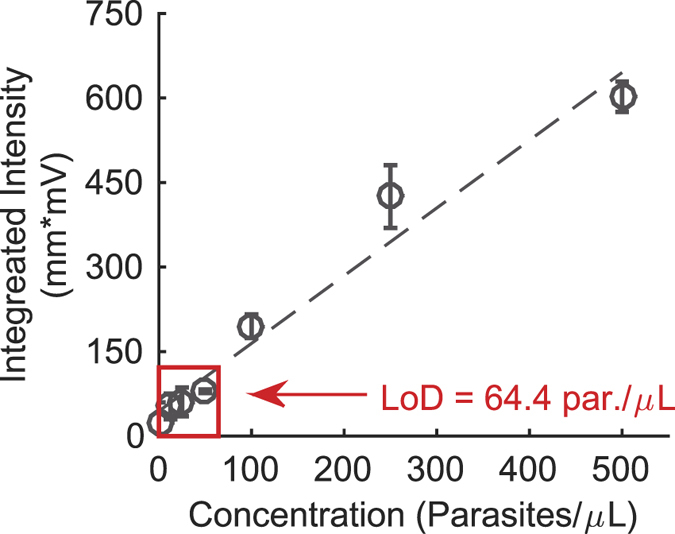
Integrated intensities (mean +/− standard deviation, n = 3 for each concentration) used for the Qiagen lateral flow reader limit of detection determination.The dashed line is the linear fit of the data between 0 parasites per microliter and 500 parasites per microliter.